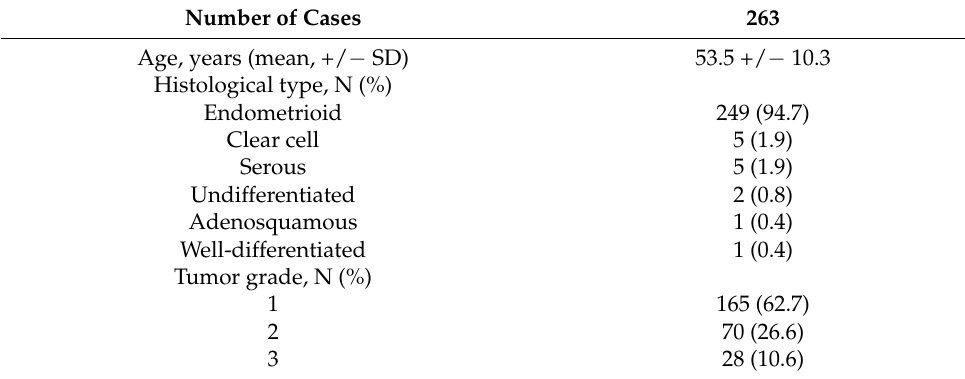
Table 1. Patients’ Characteristics.